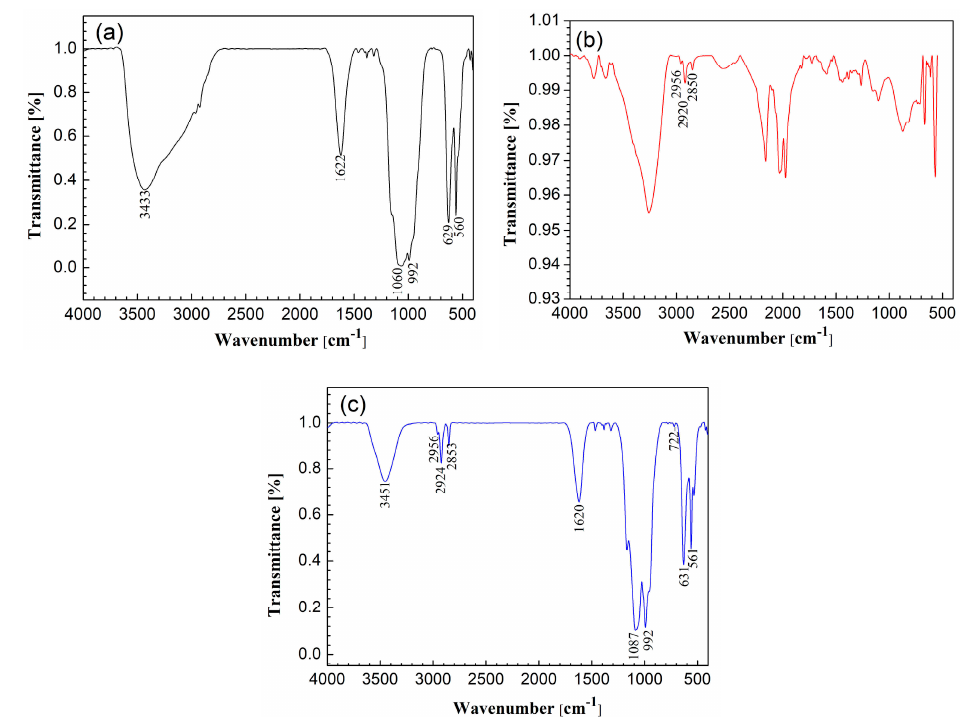
Figure 4. FTIR spectra of ( a ) copper surface treated with H 3 PO 4 solution; ( b ) copper surface with 1- dodecanethiol SAM; and, ( c ) copper surface treated with H 3 PO 4 solution and modified with 1- dodecanethiol